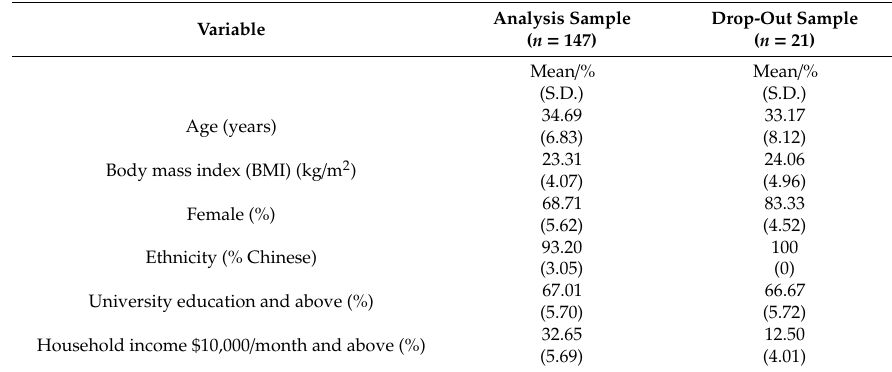
Table 1. Descriptive statistics.